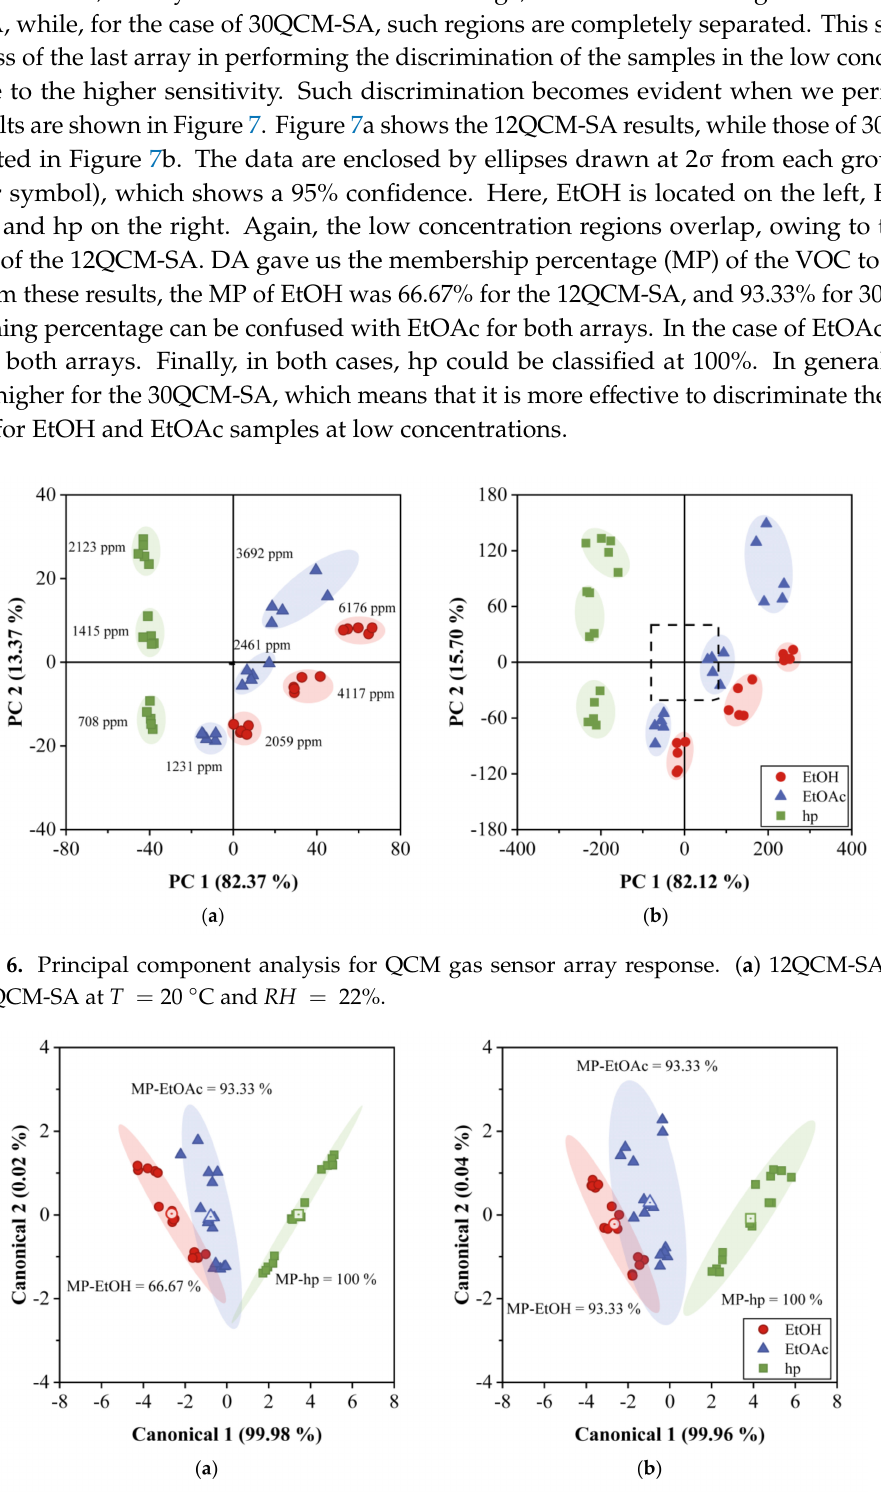
Figure 7. Discriminant analysis for QCM gas sensor array response. ( a ) 12QCM-SA and ( b ) 30QCM-SA at T = 20 ◦ C and RH = 22%. Ethanol, ethyl acetate, and heptane data are enclosed by ellipses calculated at 2 σ